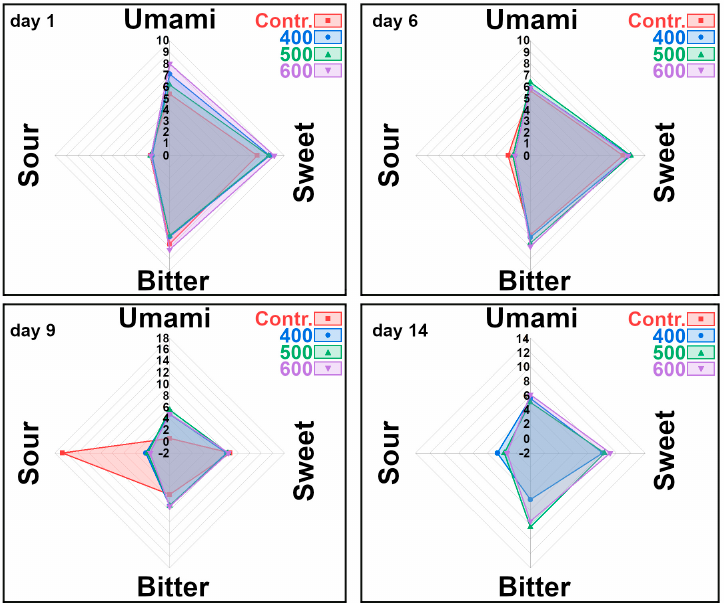
Figure 4. Overall umami, sour, sweet, and bitter taste activity by compounds detected by 1 H-NMR in control and treated (400, 500, 600 MPa) striped prawns’ samples on days 1, 6, 9, and 14.